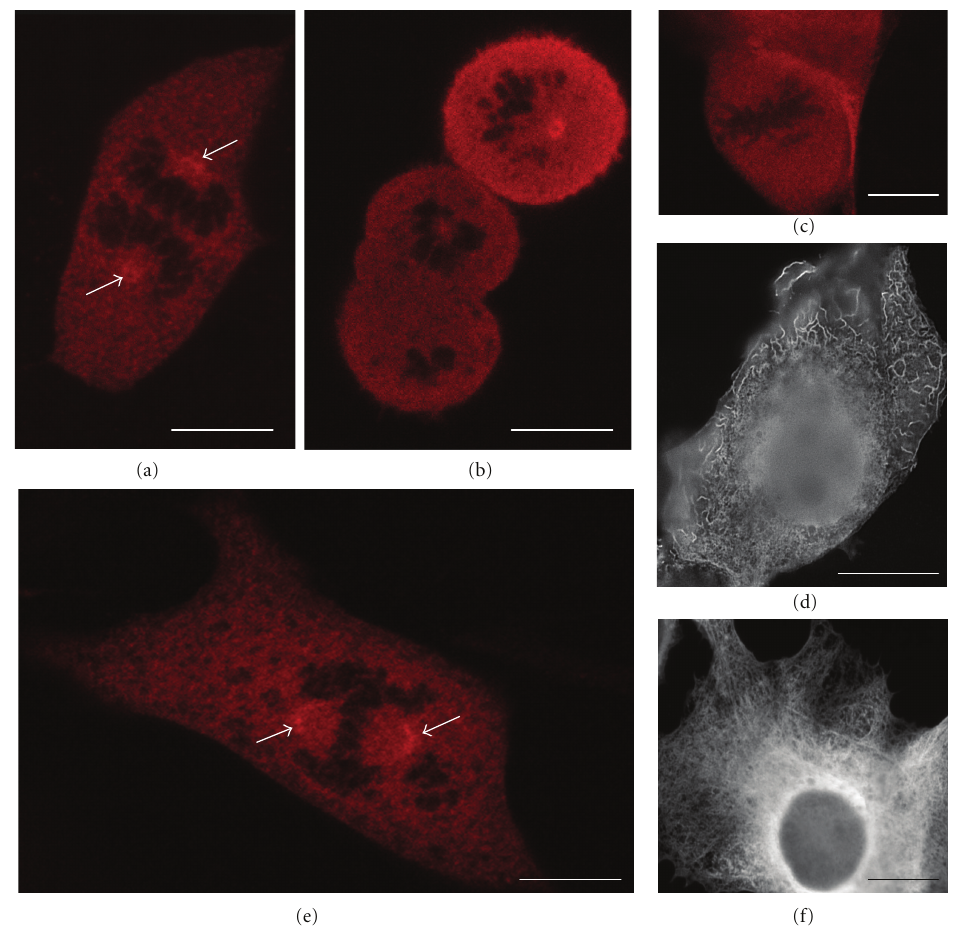
Figure 2: Expression of Myc-XlTCTP in Xenopus laevis XL2 cells. (a) Confocal section of XL2 cell in anaphase with high concentration of XlTCTP at the spindle poles (white arrows). (b) Confocal section of two dividing XL2 cells with high concentration of XlTCTP at the spindle poles. (c) Control mitotic XL2 cells expressing Myc tag only. (d) Interphase XL2 cell expressing Myc-XlTCTP. XLTCTP is localized in distinct fibers in the cytoplasm. (e) Mitotic murine NIHT3T cell expressing Myc-XlTCTP. High concentration of XlTCTP is present at the spindle poles (white arrows). (f) Interphase murine NIH3T3 cells expressing Myc-XlTCTP. Note that XlTCTP forms MT-like fibers in the cytoplasm. Bar is equal to 20 μ